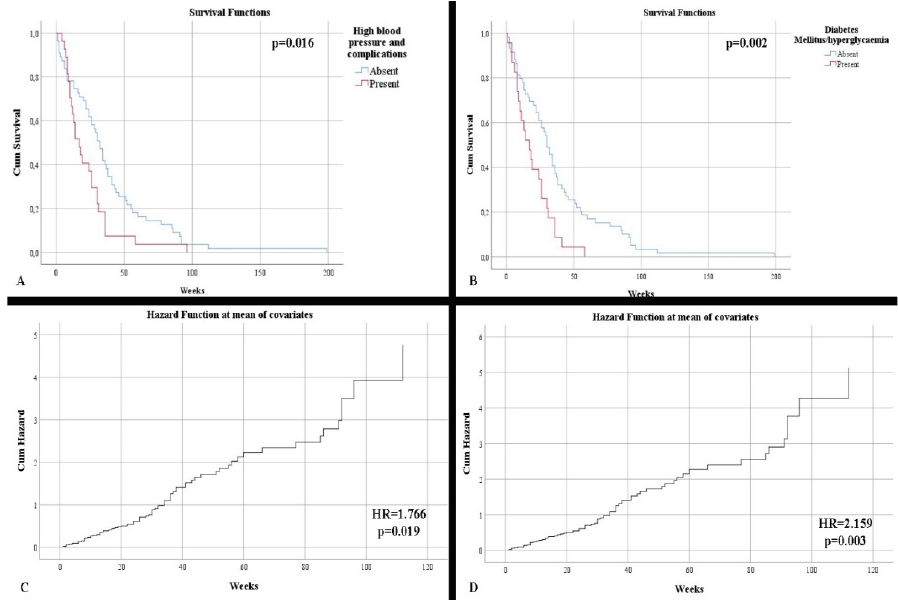
Figure 1. ( A ) Kaplan–Meier survival graphic that shows a lower survival rate for patients with high blood pressure. ( B ) Univariate cox regression analysis that demonstrates the risk of death in presence of high blood pressure. ( C ) Kaplan–Meier survival graphic that shows a lower survival rate for patients with diabetes or hyperglycemia. ( D ) Univariate cox regression analysis that demonstrates the risk of death in presence of diabetes mellitus or hyperglycemia. 3.2. Imaging Features The main imaging technique used was CT in 92.94% of cases, with magnetic reso ‐ nance imaging being performed by only 51.76% of patients. CT accuracy was 90.54%, identifying lesions with malignant features, most likely glioblastomas. Magnetic reso ‐ nance imaging had a similar accuracy (90.91%). Most gliomas were supratentorial (95.29%), with four cases located in the cerebellum. An association between symptomatology and tumor localization was noted. Supratento ‐ rial lesions were statistically significantly associated with motor deficits ( p = 0.012), while infratentorial lesions were associated with balance and coordination disorders ( p < 0.001). A slight predominance of lesions was observed in the left hemisphere (51.76%); however, lesions located in the right hemisphere were associated with the presence of intracranial hypertension ( p = 0.023). The survival rate in the case of localization in the right hemi ‐ sphere was higher (39.32 weeks with right hemisphere localization vs. 26.92 weeks with ‐ out), though it was not a statistically significant correlation ( p = 0.092). The temporal lobe was the site of most grade 4 gliomas (22.35%). Corroborating the data with the clinical picture, the frontally and parietally located gliomas were statistically significantly associ ‐ ated with the appearance of epileptic seizures and cognitive disorders ( p < 0.001 and p = 0.033, respectively). The average maximum diameter of the lesion was 51.04 mm (10–87), with approxi ‐ mately half of the gliomas having a diameter of over 50 mm (47.06%). The mean tumor volume was 88.05 cm3 (0.90–388.94). Increased tumor volume was associated with the presence of headaches and intracranial hypertension ( p < 0.001 and p < 0.001, respectively). Peritumoral edema of over 5 mm was observed in 94.12% of cases. The midline shift showed an average of 8.52 mm. A higher displacement was associated with a younger age at presentation ( p = 0.010). Control imaging, performed after surgery, noted complete tumor ablation in only 23.53% of cases. This aspect was also reflected in terms of survival until the end of the